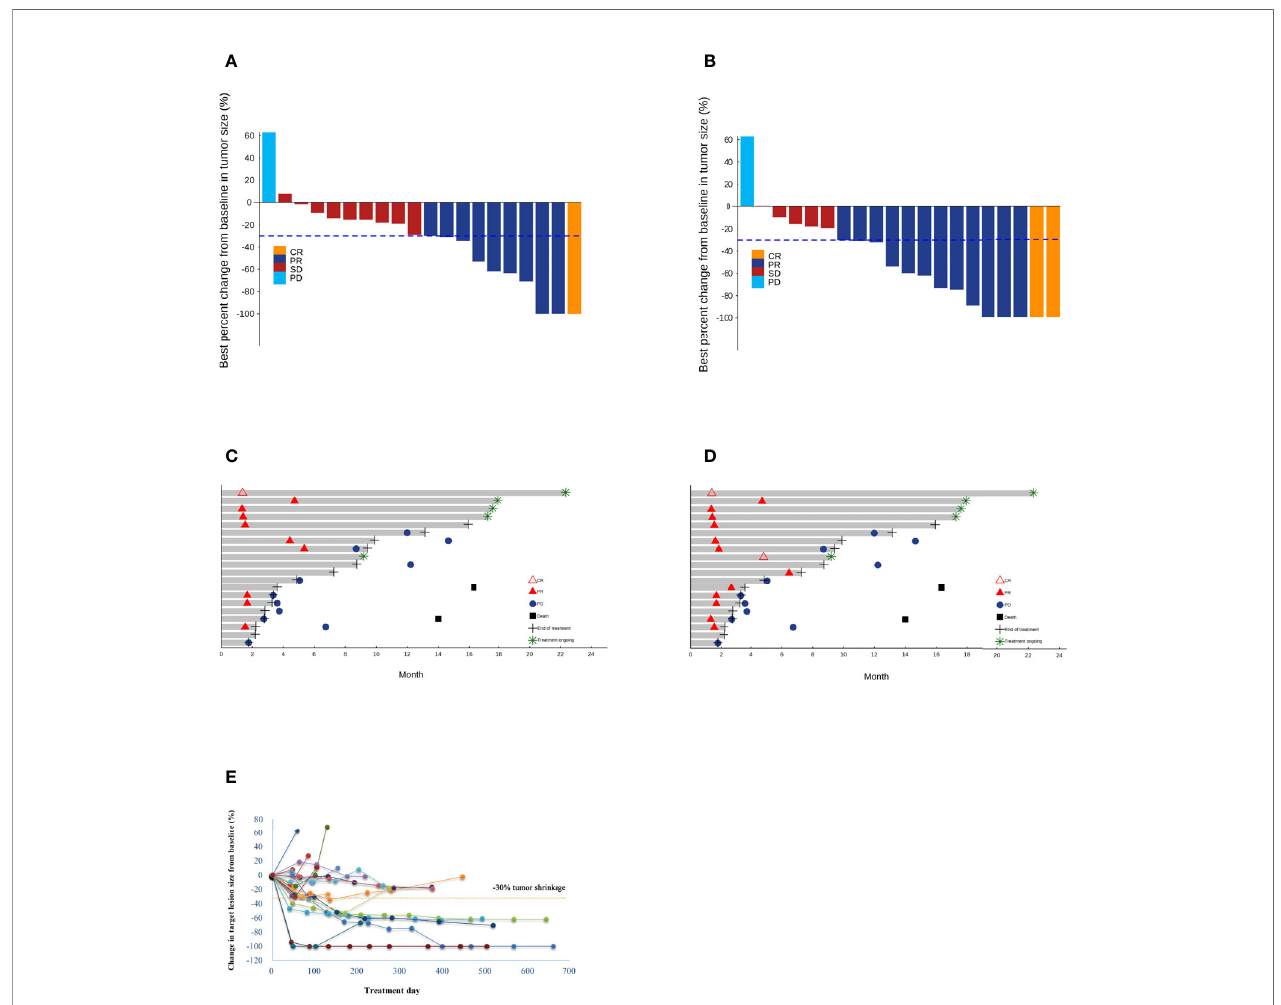
FIGURE 2 | Waterfall plots of the best percentage changes for the sum of target lesion diameters after treatment are shown for individual patients with best objective response per RECIST v1.1 (A) and modi fi ed RECIST (B) as indicated by the color codes. Both investigator-con fi rmed and uncon fi rmed responses are included. The dotted line indicates a 30% reduction in the target lesion size. Swimmer plots of time to tumor response (months) of individual unresectable or metastatic hepatocellular carcinoma patients. Responses were evaluated by RECIST v1.1 (C) and modi fi ed RECIST (D) . Each bar represents one patient in the ef fi cacy-evaluable population. CR, complete response; PD, progressive disease; PR, partial response; SD, stable disease. (E) The spider plot presents individual changes in tumor measurements over time relative to baseline tumor burden in the study patients. Patients are coded in different